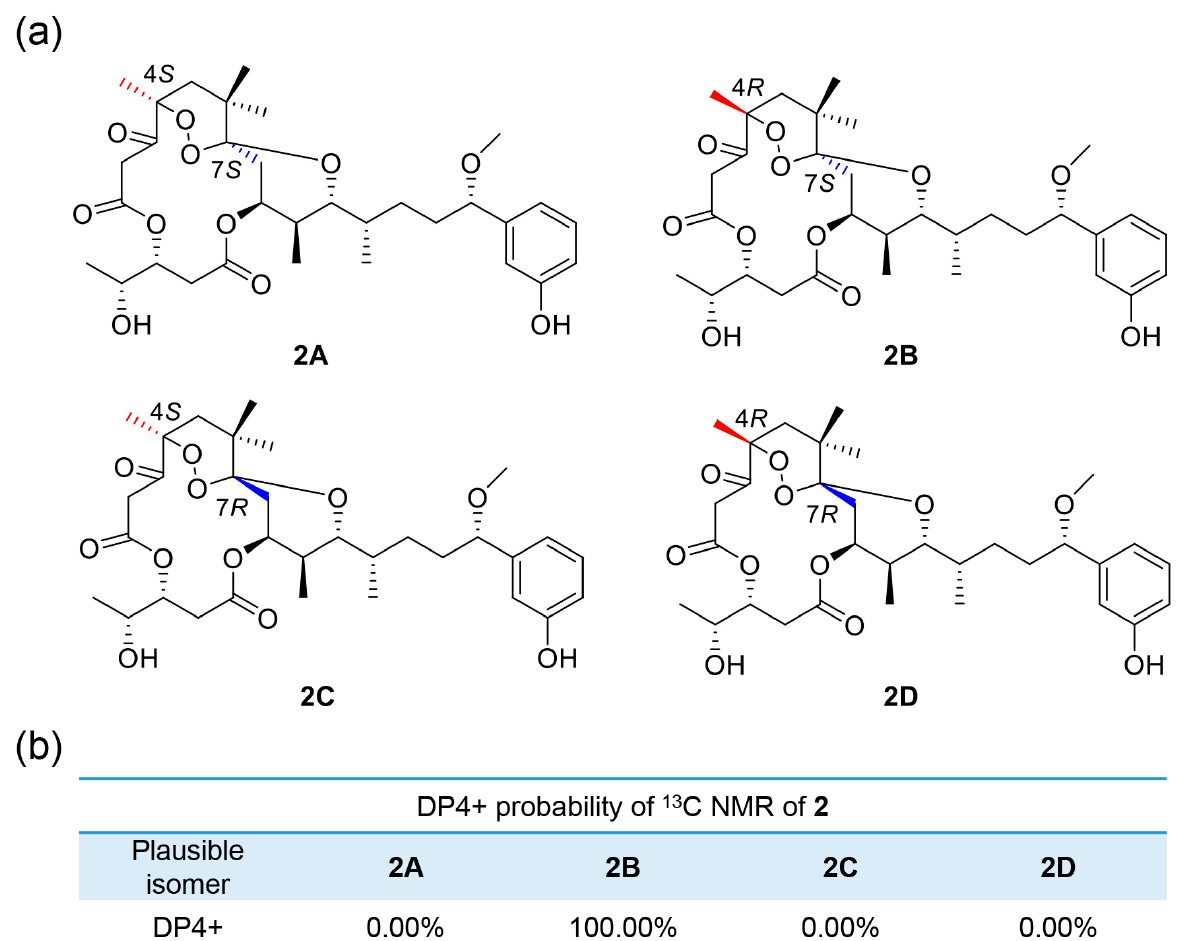
13 C values of 2